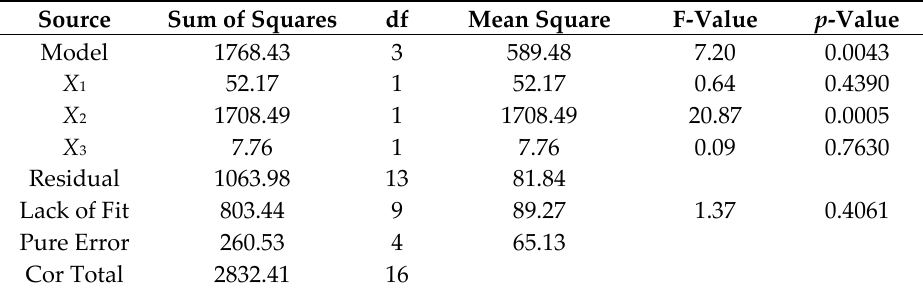
Table 4. Variance analysis of liner model of substrate